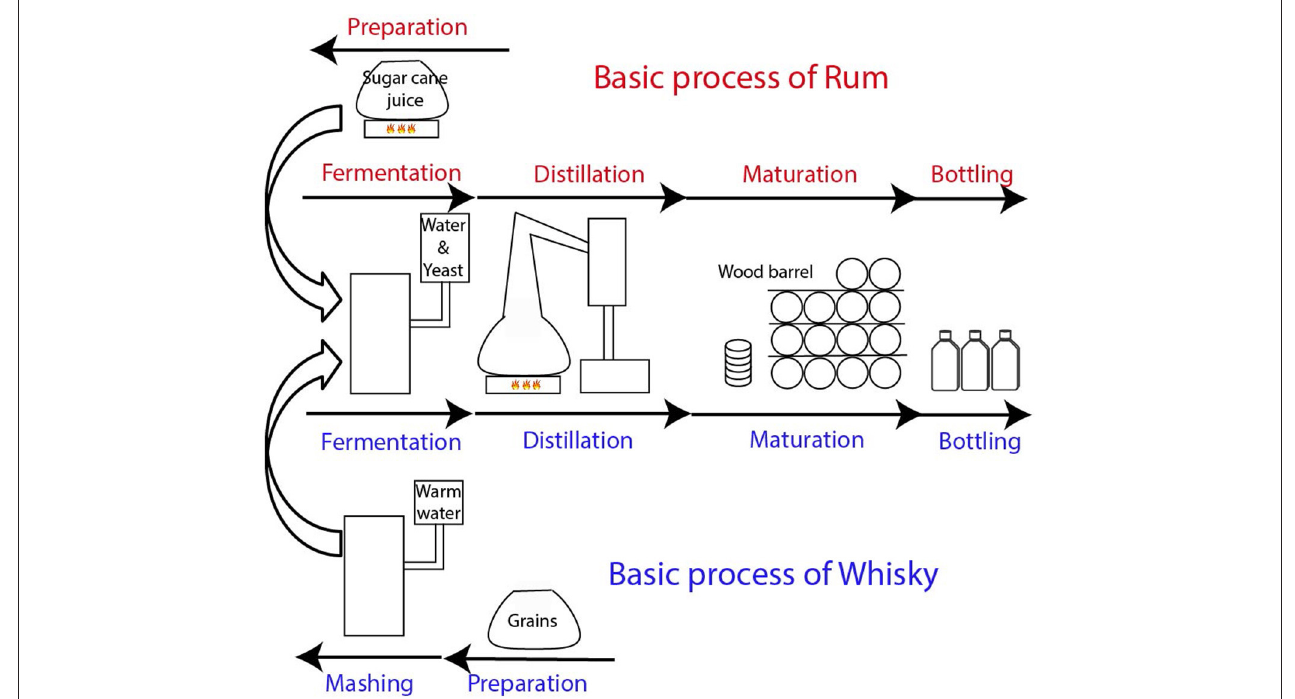
FIGURE 4 | Representation of the basic elaboration process of rum and whisky.